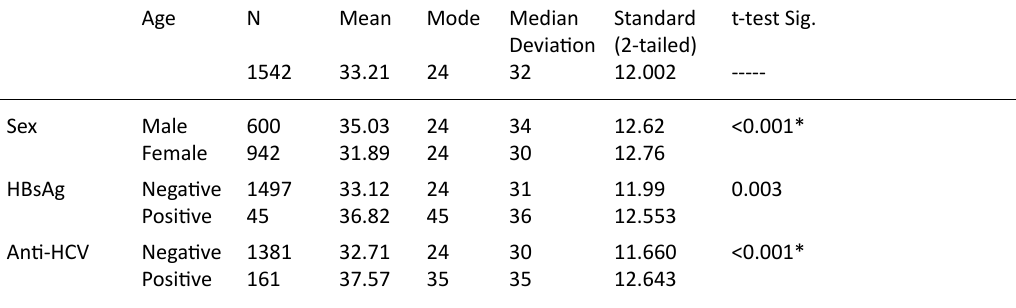
Table 1. Comparison of age between different